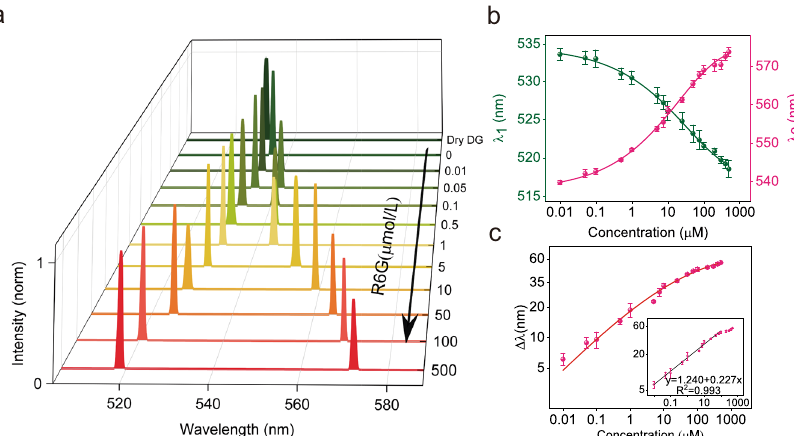
Fig. 3 | The FRET-WGM sensing system. a Dose-dependent lasing spectra (only showing the CWL) of DG and R6G displaying wavelength blue-shift of DG and red- shiftofR6GwithincreaseofR6Gconcentration. b Meanwavelength-concentration plot ofDG(green)and R6G (pink)of fi ve experiments.Dataare presented asmean